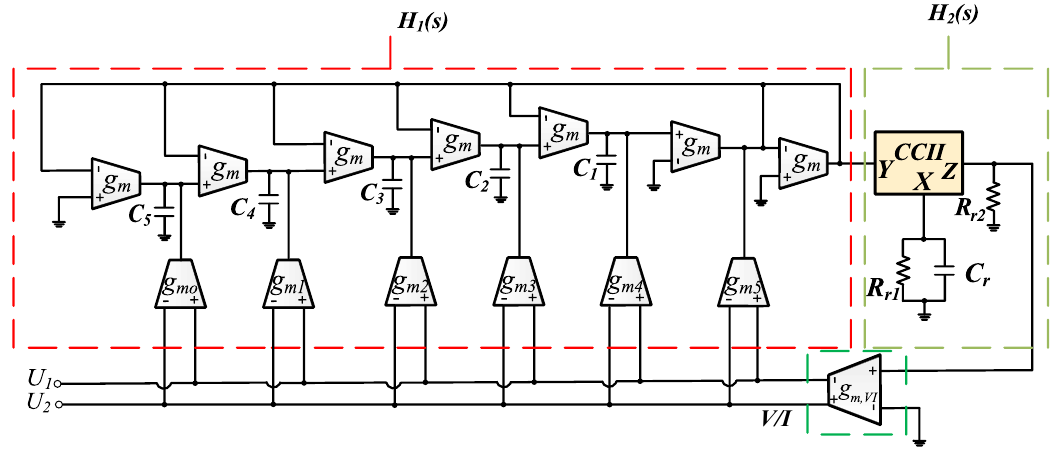
Figure 4. Fractional-order capacitor emulator (versatile methodology)